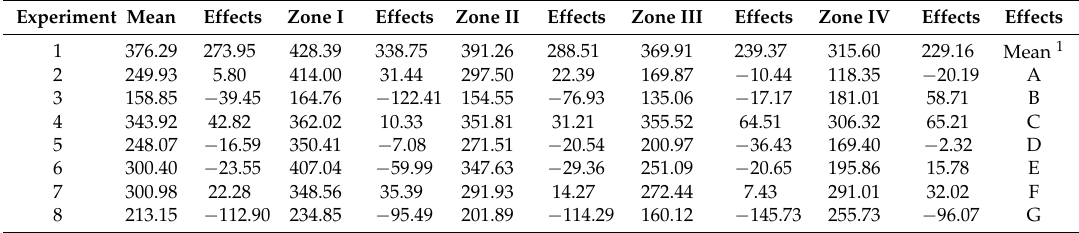
Table 8. Calculation of the Effects by means of Yates’ Algorithm for N A (number of counts per mm 2 ). Experiment Mean Effects Zone I Effects Zone II Effects Zone III Effects Zone IV Effects